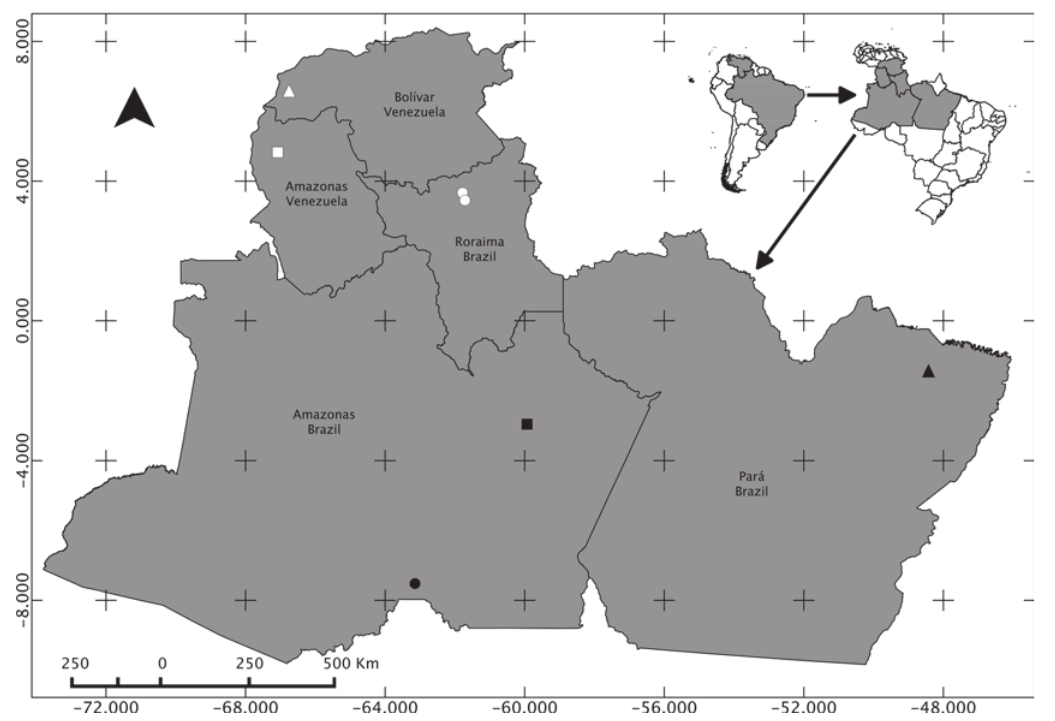
Figure 10. Map showing the distribution of Avima anitas sp. nov. ( (cid:123) ) and the geographically nearest species: A. albimaculata ( (cid:85) ),